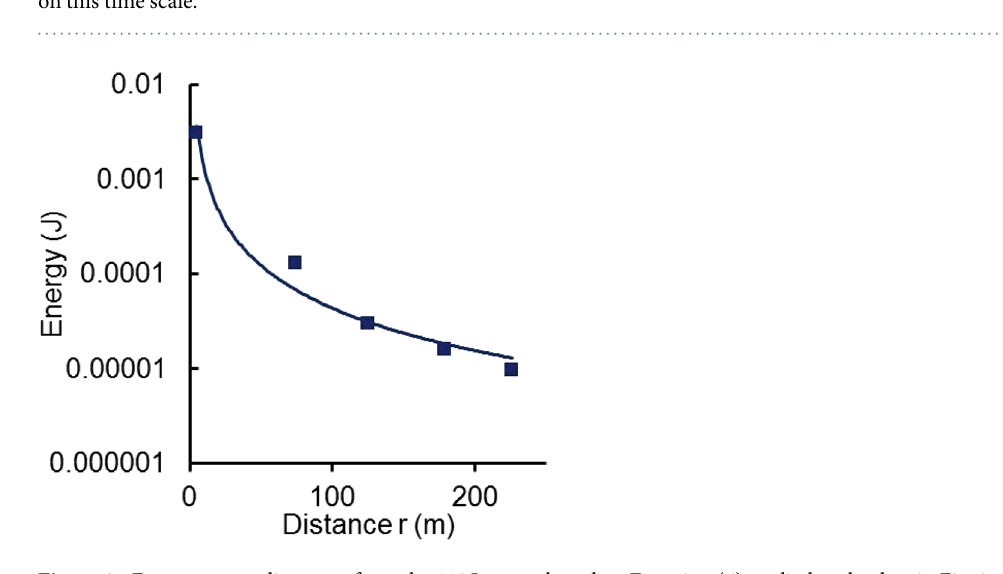
Figure 9. Energy versus distance r from the 112 J source based on Equation (6) applied to the data in Fig.